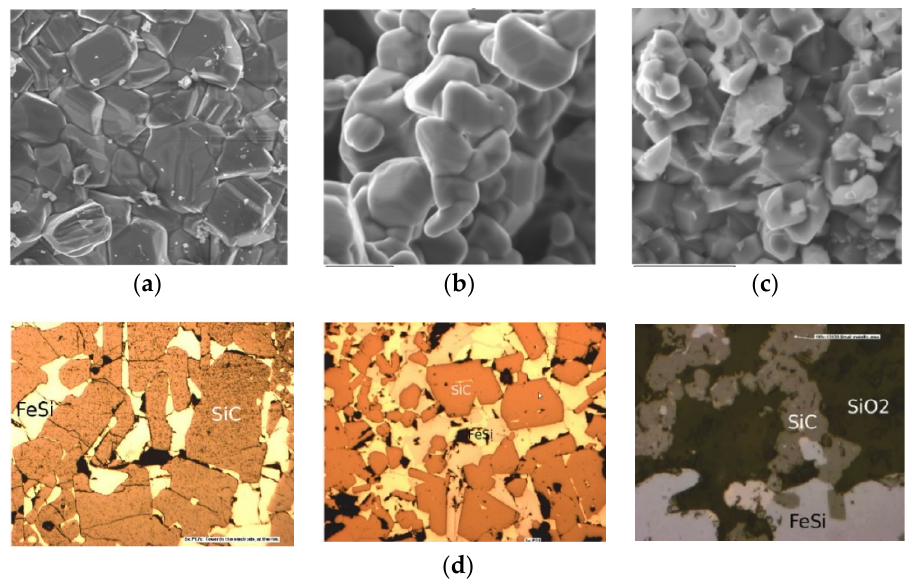
Figure 13. Microstructure comparison of silicon carbide formed in the tests: quartzite Ukraine ( a ), quarzite Slovakia ( b ), quartz Spain ( c ), and in the industrial EAF [5] ( d ). Table 10. Ranking of quartz and quartzite samples in comprehensive evaluation (according to Figure 2). Laboratory Testing.